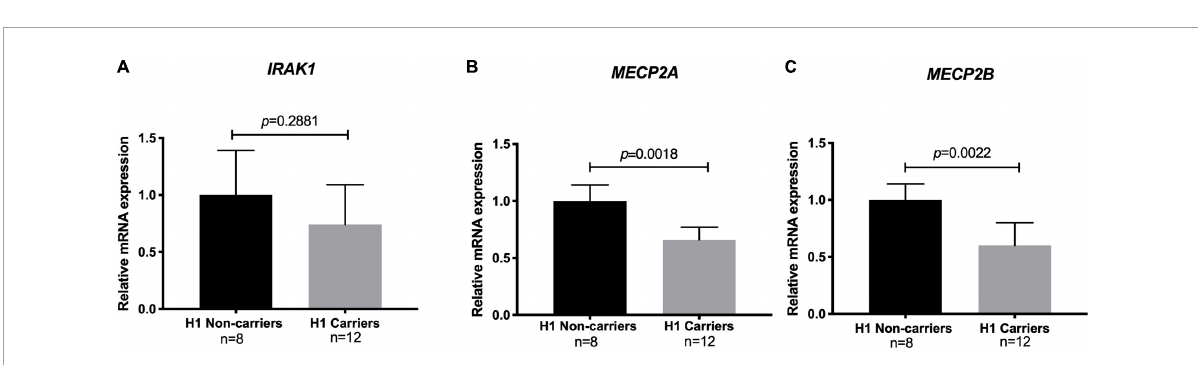
FIGURE3 Relative mRNA levels of methyl CpG binding protein 2 ( MECP2) isoforms and interleukin-1 receptor associated kinase 1 ( IRAK1) among risk haplotype Xq28 carriers. (A) IRAK1 . (B) MECP2 isoform A. (C) MECP2 isoform B. Transcript expression was normalized to GAPDH (log 2 fold change > 2 and adjusted p <